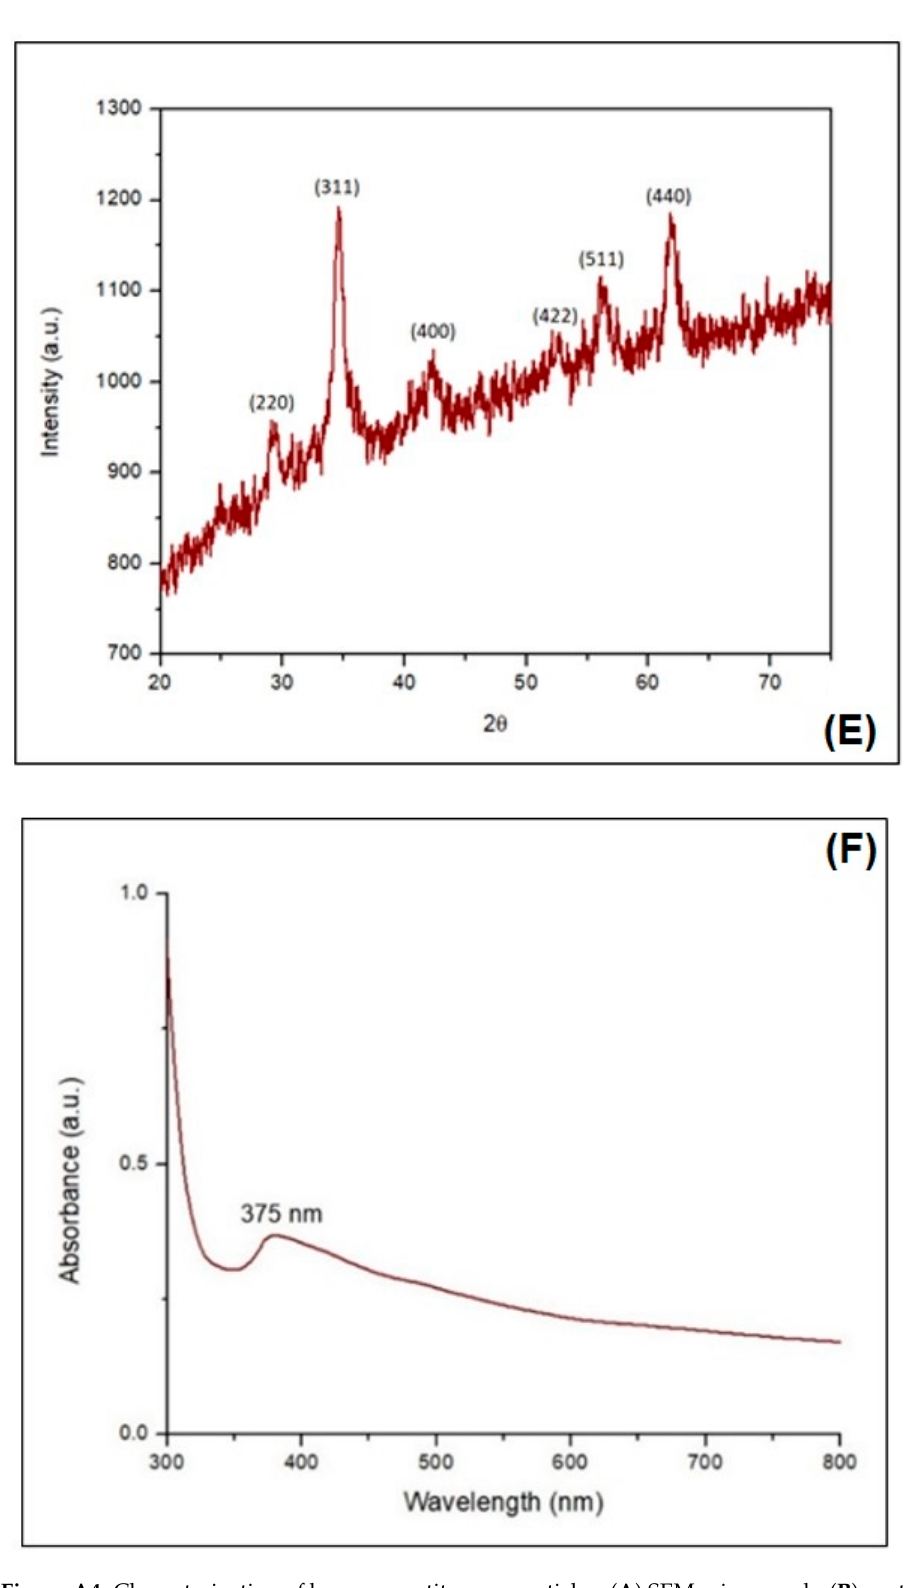
Figure A4. Characterization of bare magnetite nanoparticles. ( A ) SEM micrograph. ( B ) particle size distribution, ( C ) Elemental analysis, ( D ) Percentage weight of different elements, ( E ): XRD pattern, ( F ) UV-VIS spectrum.